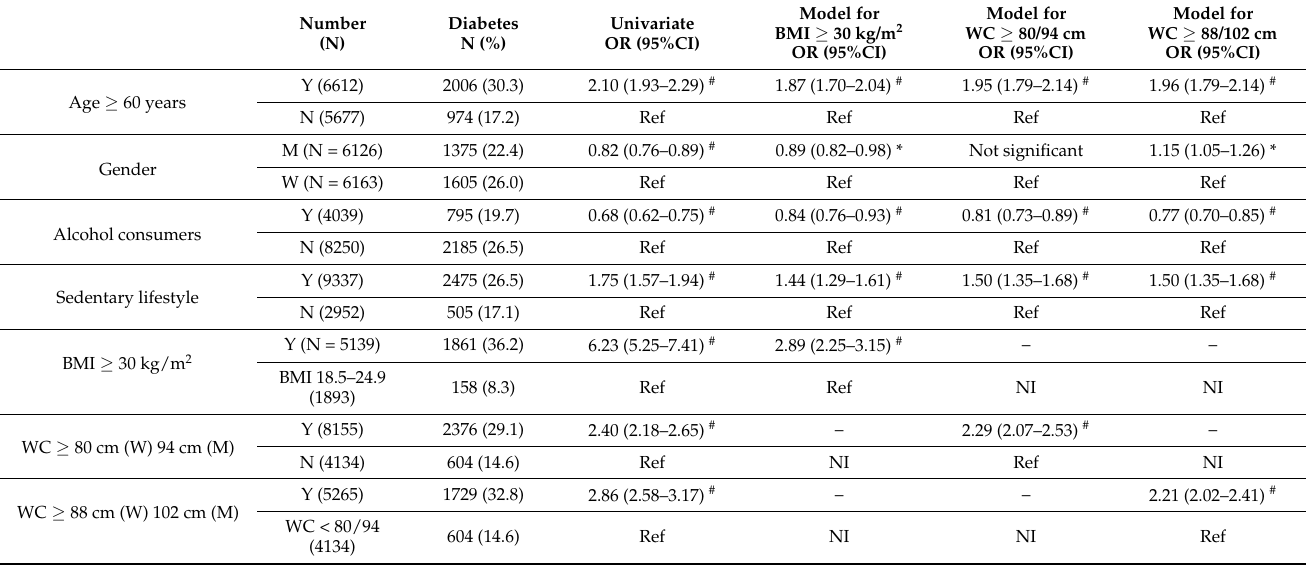
Table 4. Results of univariable and multivariable logistic-regression analyses presenting factors associated with the occurrence of